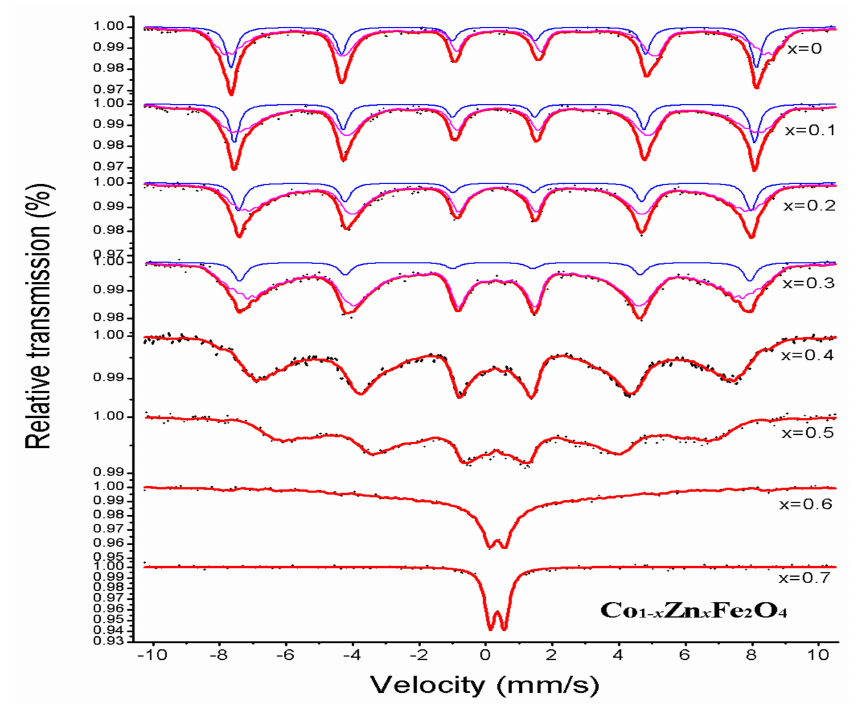
Figure 6. The Mössbauer spectra of Co 1 − x Zn x Fe 2 O 4 sintered at 800 ◦